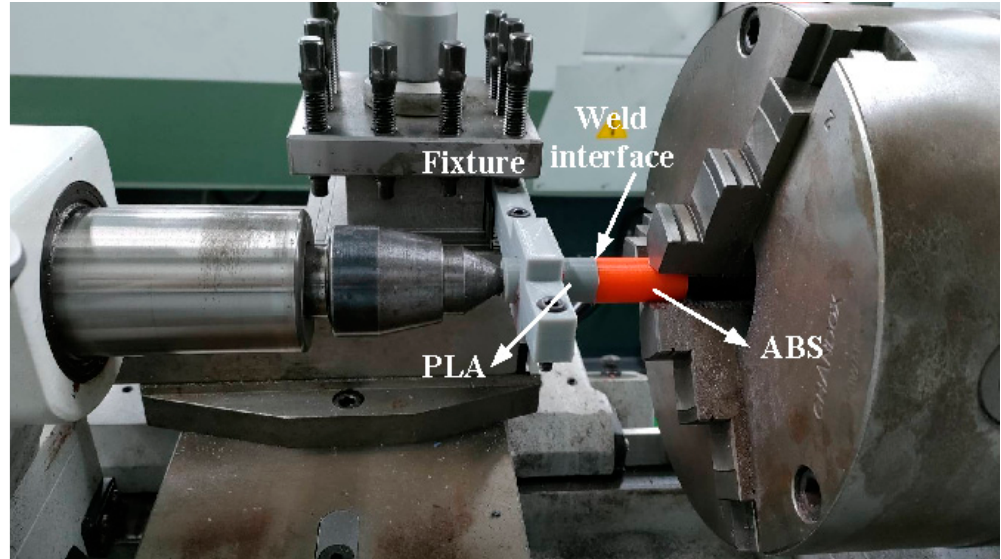
Figure 4. FRW of PLA to ABS rods.